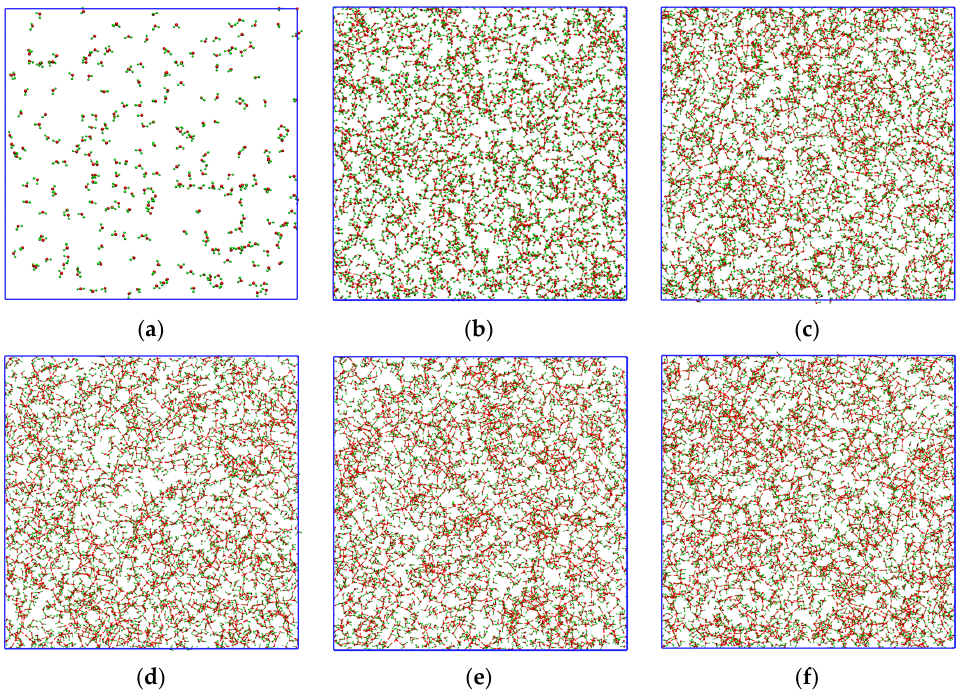
Figure 3. Spatial distribution of highly ordered water molecules (HOWMs) in 0.6 solution at different simulation time points: ( a ) t = 0.0 ns; ( b ) t = 0.1 ns; ( c ) t = 1.0 ns; ( d ) t = 3.0 ns; ( e ) t = 6.0 ns; ( f ) t = 10.0 ns.